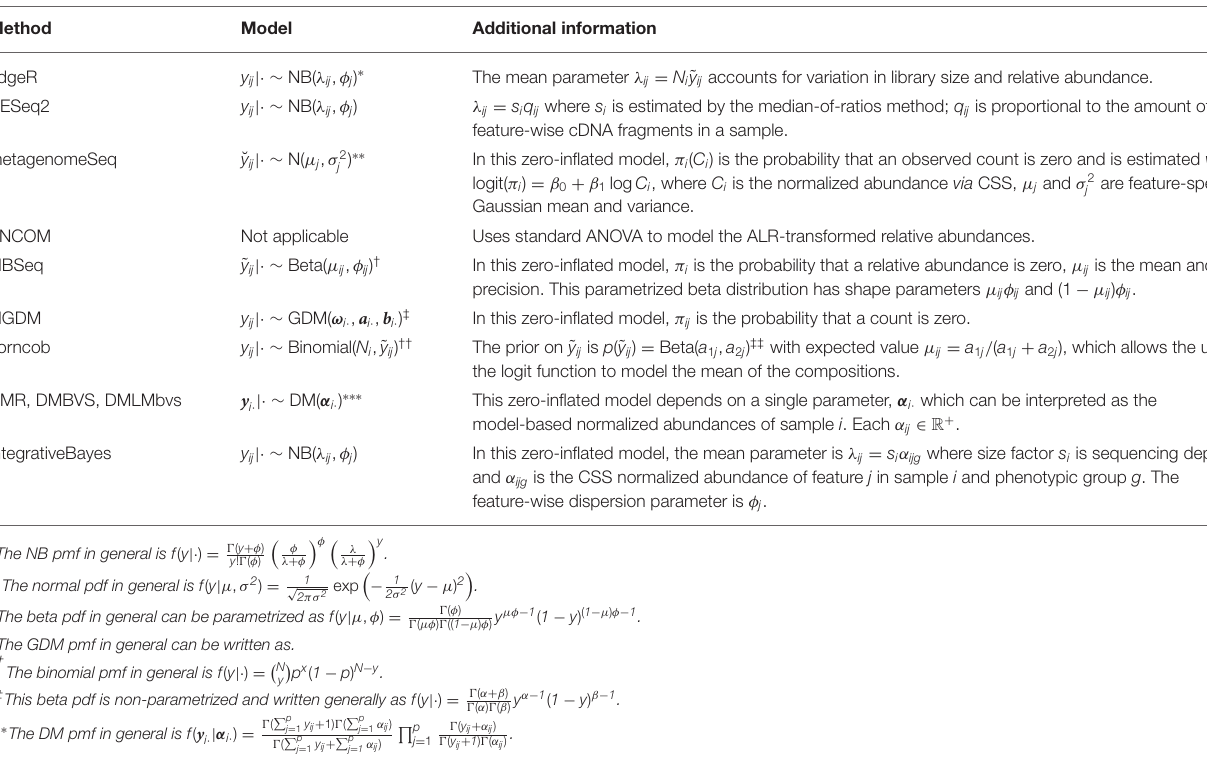
TABLE 5 | Summary of the count data models that appear throughout this paper.